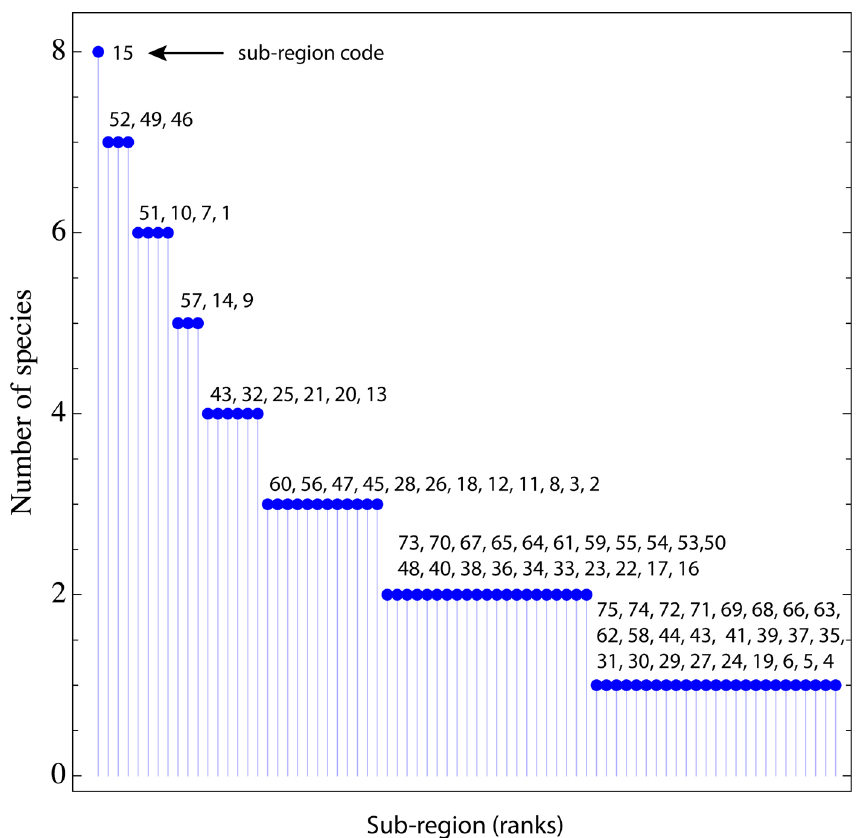
Figure 4. Natural sub-regions ranked in terms of species